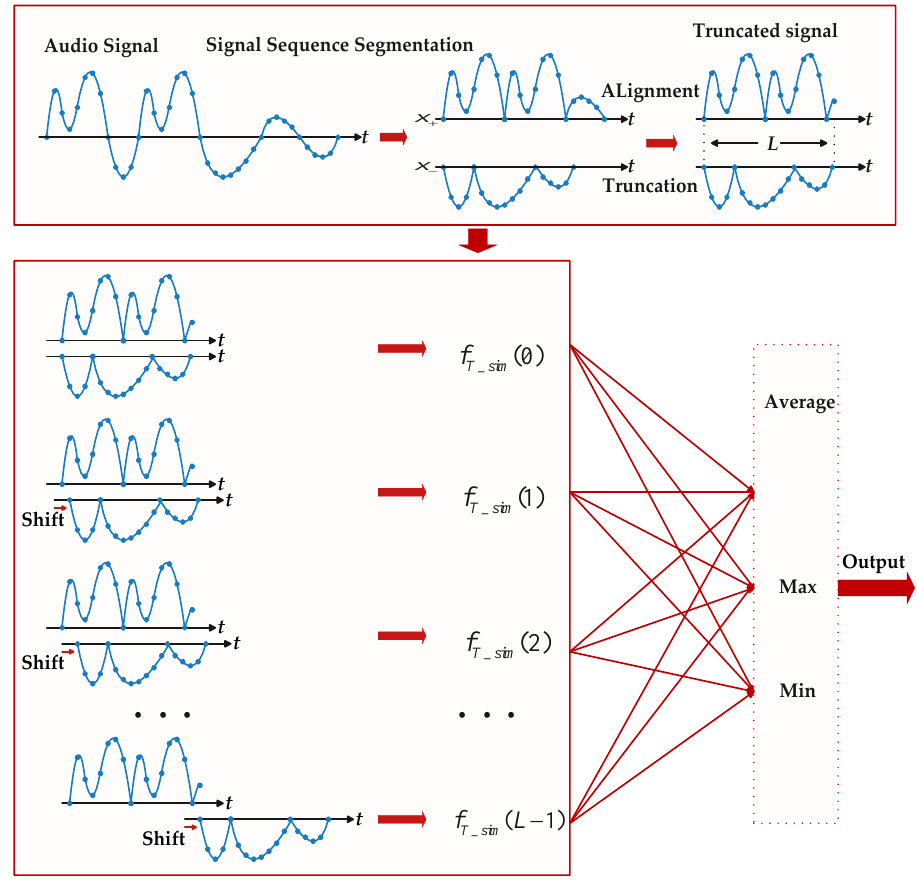
Figure 2. The signal positive and negative waveform amplitude similarity feature calculation pro- cess.